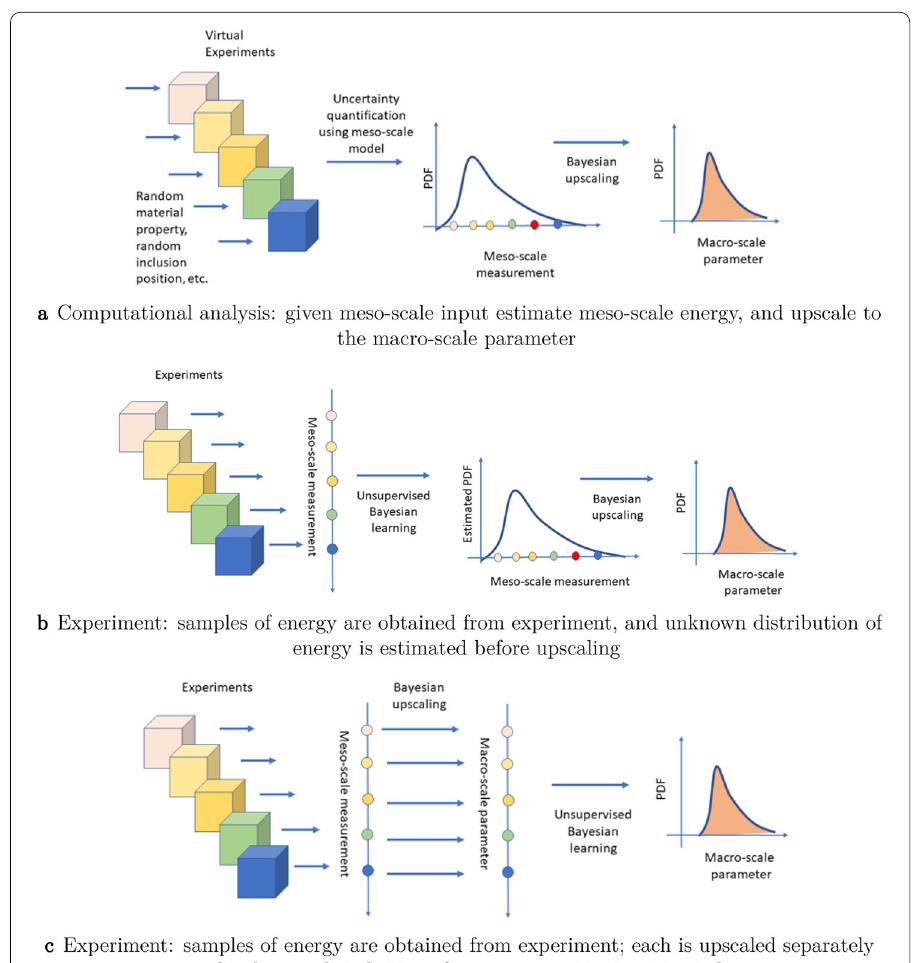
Fig. 1 Stochastic multi-scale